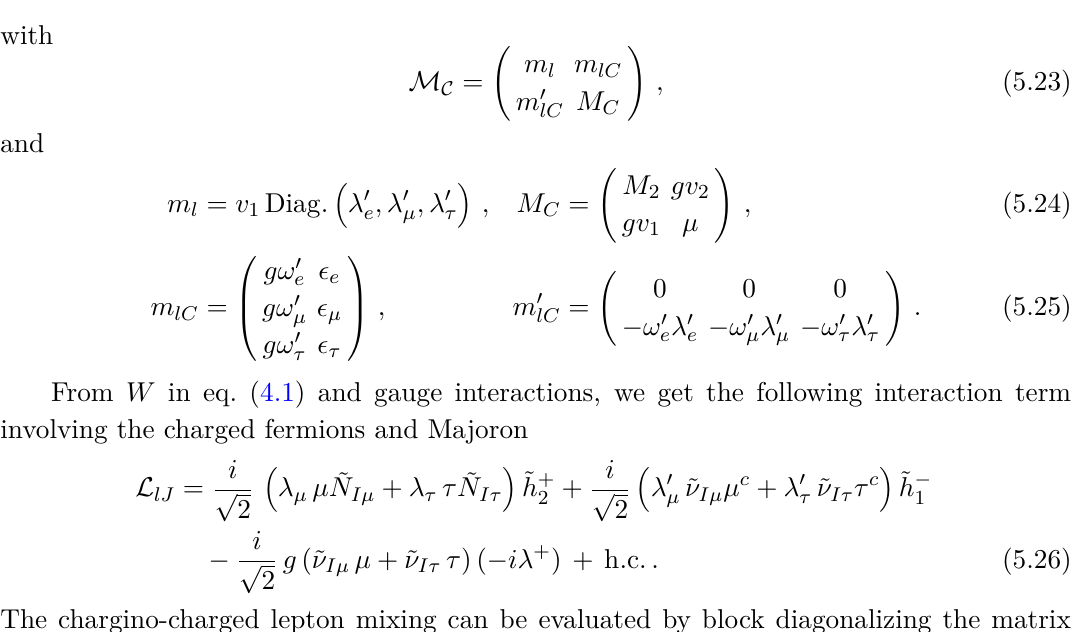
Table 2 . Predictions for the largest diagonal coupling of neutrinos with Majoron, off-diagonal couplings relevant for neutrino decays and the corresponding neutrino lifetime for the benchmark